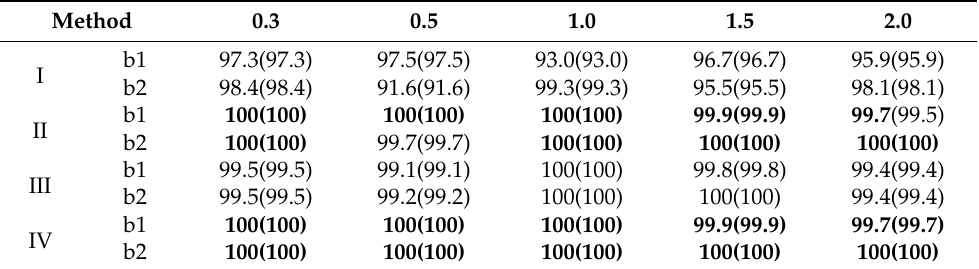
Table 2. SFSE ambiguity fixing rate and correct fixed rate of various designed and actual baseline lengths (GPS + BDS observations, open sky).